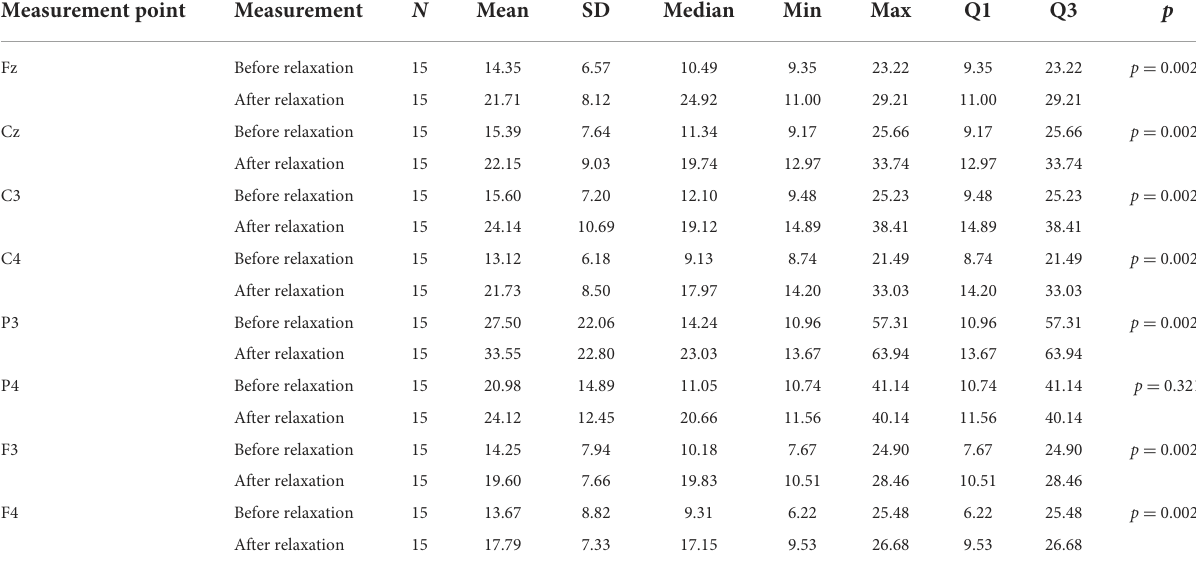
TABLE 2 Comparison of Alpha wave amplitudes before the SKY course (first day) and after the whole SKY course (third day) with eyes closed. Measurement